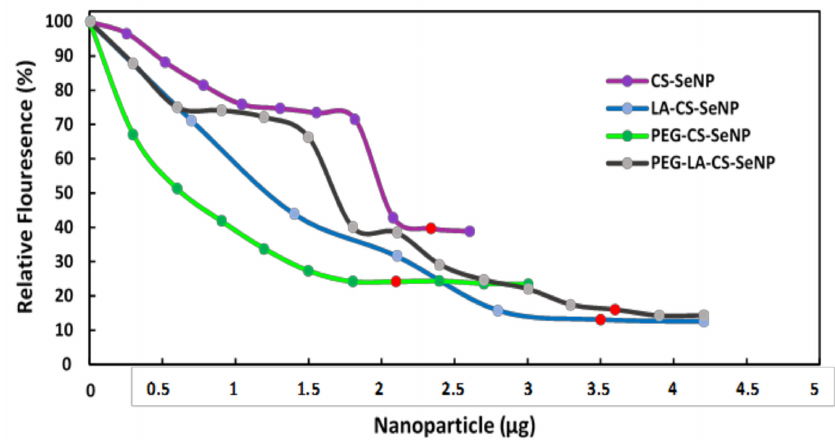
Figure 6. Ethidium bromide intercalation assay of CS-SeNPs, LA-CS-SeNPs, PEG-CS-SeNPs, and LA-PEG-CS-SeNPs. Red dots indicate maximum compaction of mRNA by the NPs.